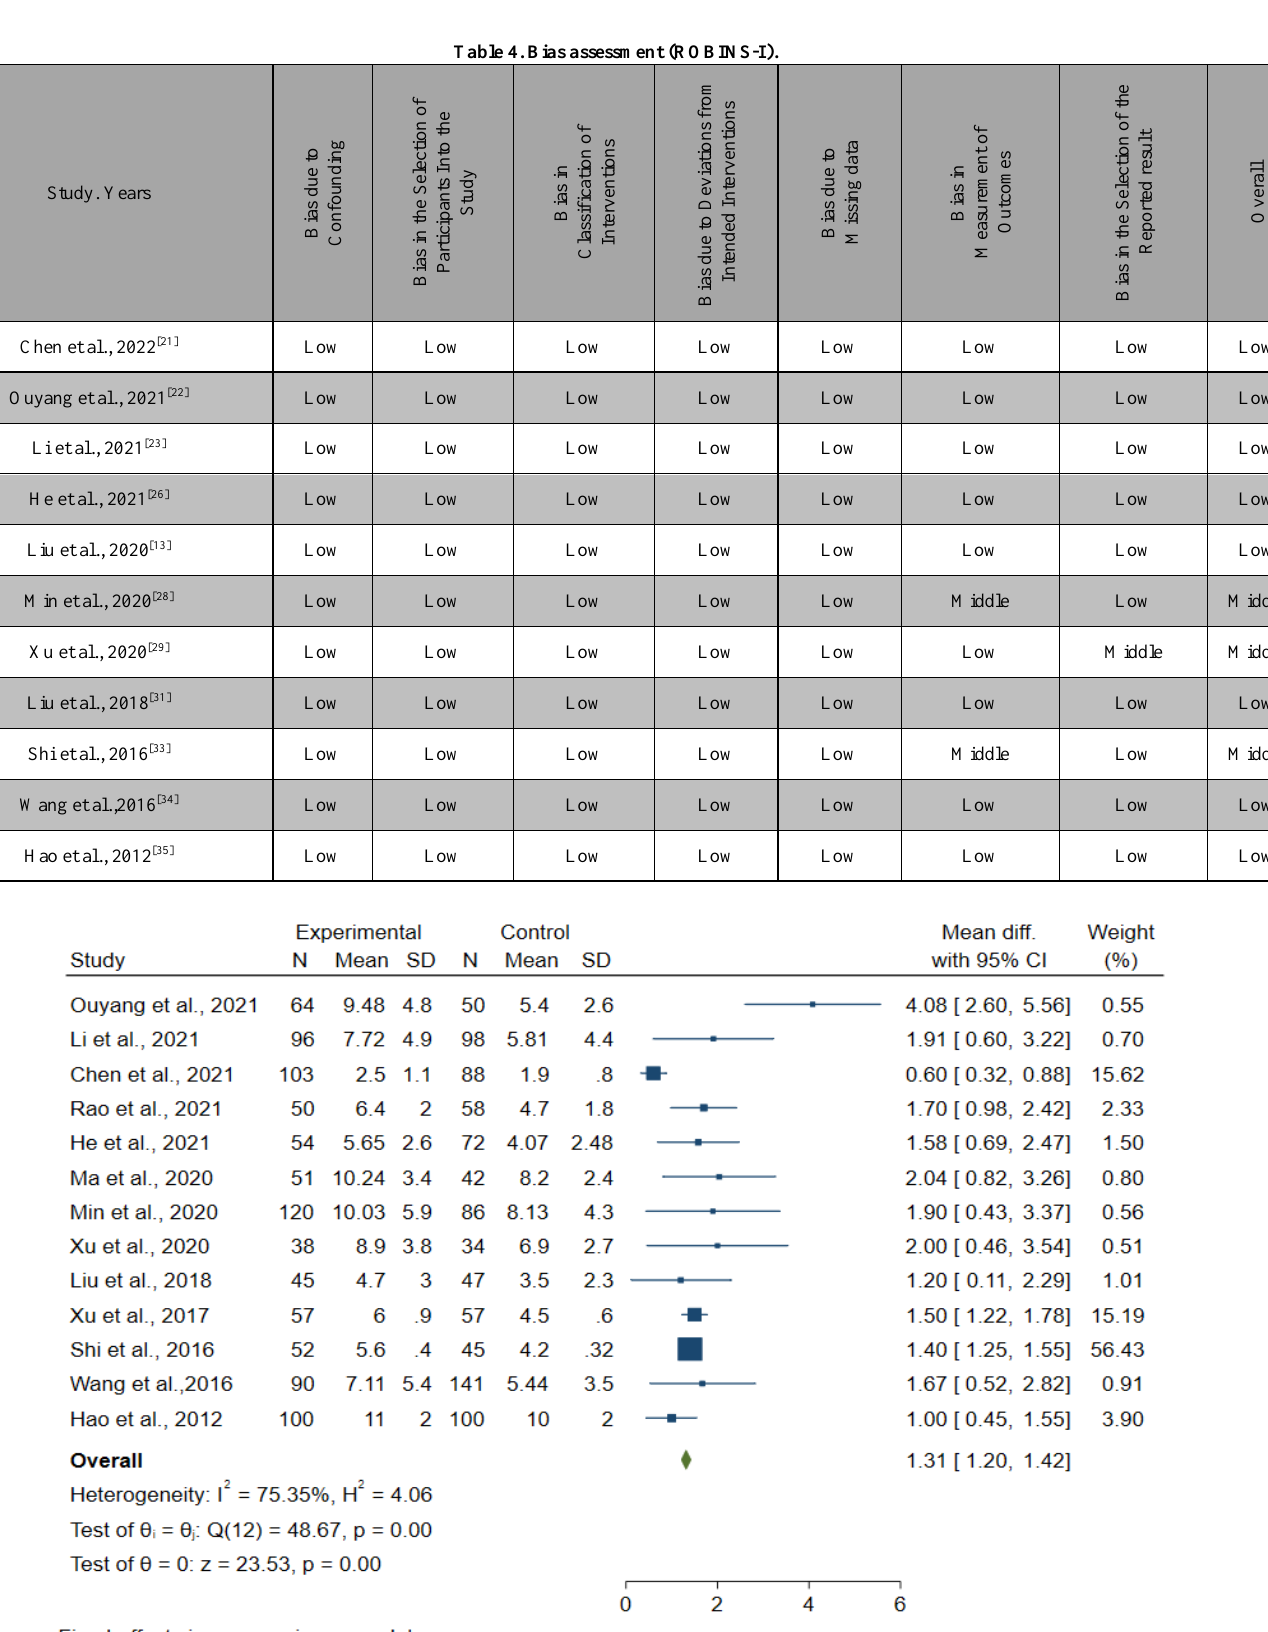
Fig. 2. The forest plot showed mean differences in lymph nodes harvested between the two